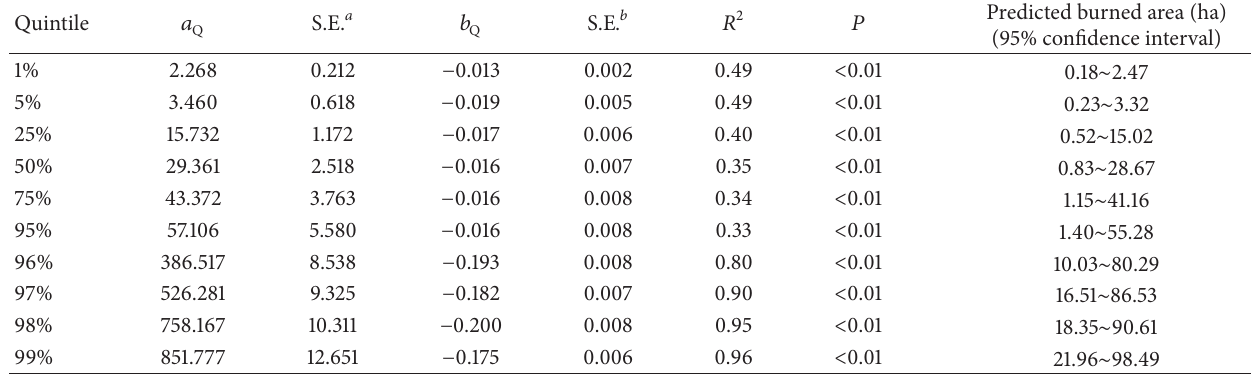
Table 3: The quintile regression equation of burned areas for different rainfall amounts.